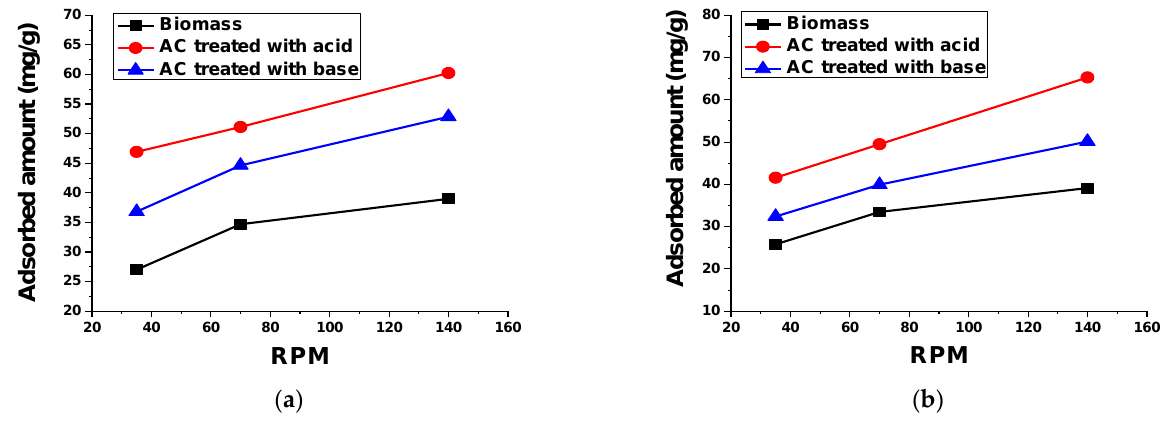
Figure 14. Effect of agitation speed on the adsorption of 50 mL ( a ) 100 mg/L TB and ( b ) 50 mg/L XO using 0.1 g biomass and AC treated with acid and base for 60 min at room temperature.